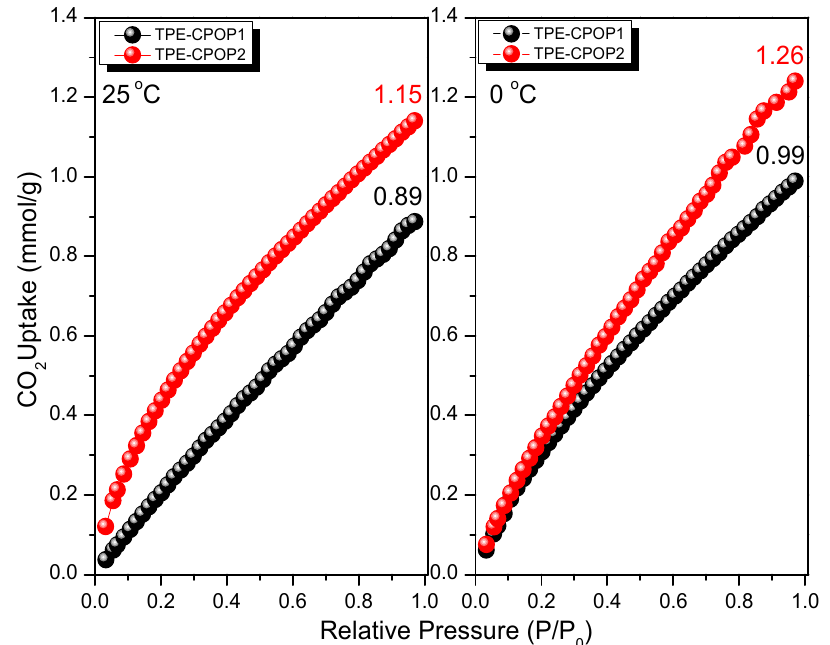
Figure 9. CO 2 uptake of TPE-CPOP1 and TPE-CPOP2 at 25 °C ( a ) and 0 °C ( b ).